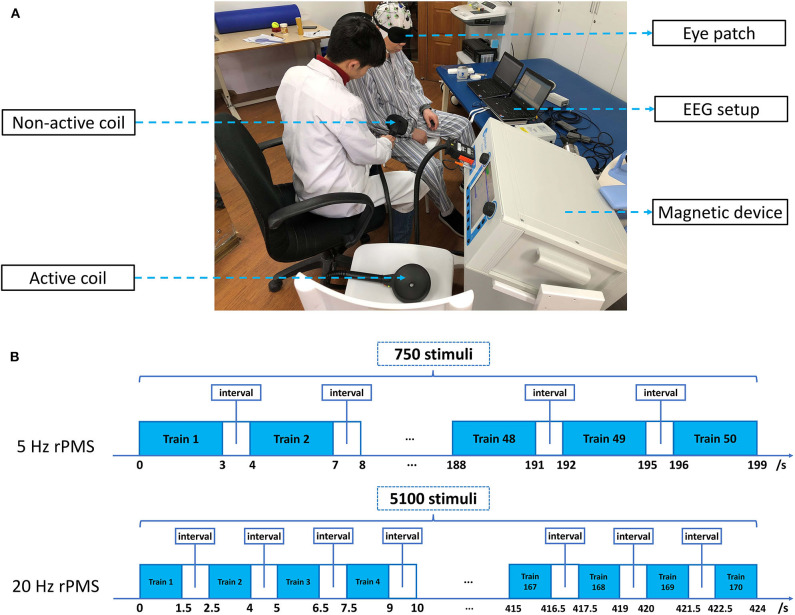
Experimental setup and intervention protocol. (A) Experimental setup for the sham group. The patient was sitting in the chair wearing an eye patch and was treated with a nonactive coil; the active coil made noises according to its normal operation as in the rPMS group. (B) Intervention protocol and the treatment block. The 5-Hz rPMS intervention comprised 50 trains of 3 s, and the 20-Hz rPMS intervention comprised 170 trains of 1.5 s. A 1-s interval was applied between each train.